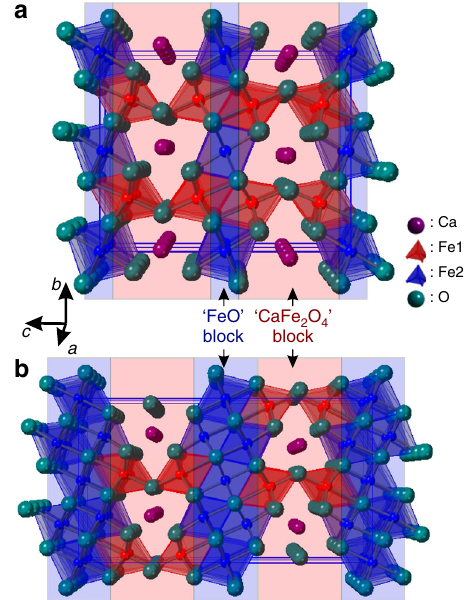
Fig. 1 Nuclear structure of CaFe 2 O 4 (FeO) n compounds. a structure of CaFe 3 O 5 ( n = 1) in Cmcm symmetry and b structure of CaFe 5 O 7 ( n = 3) (at > 360 K) in Cmcm symmetry. CaFe 3 O 5 has two Fe sites: Fe1 on the 8 f Wyckoff site and Fe2 on the 4 a Wyckoff site. The Fe1 site can be thought of as being in a CaFe 2 O 4 block, while the Fe2 site is in an FeO block, and these blocks stack along the c